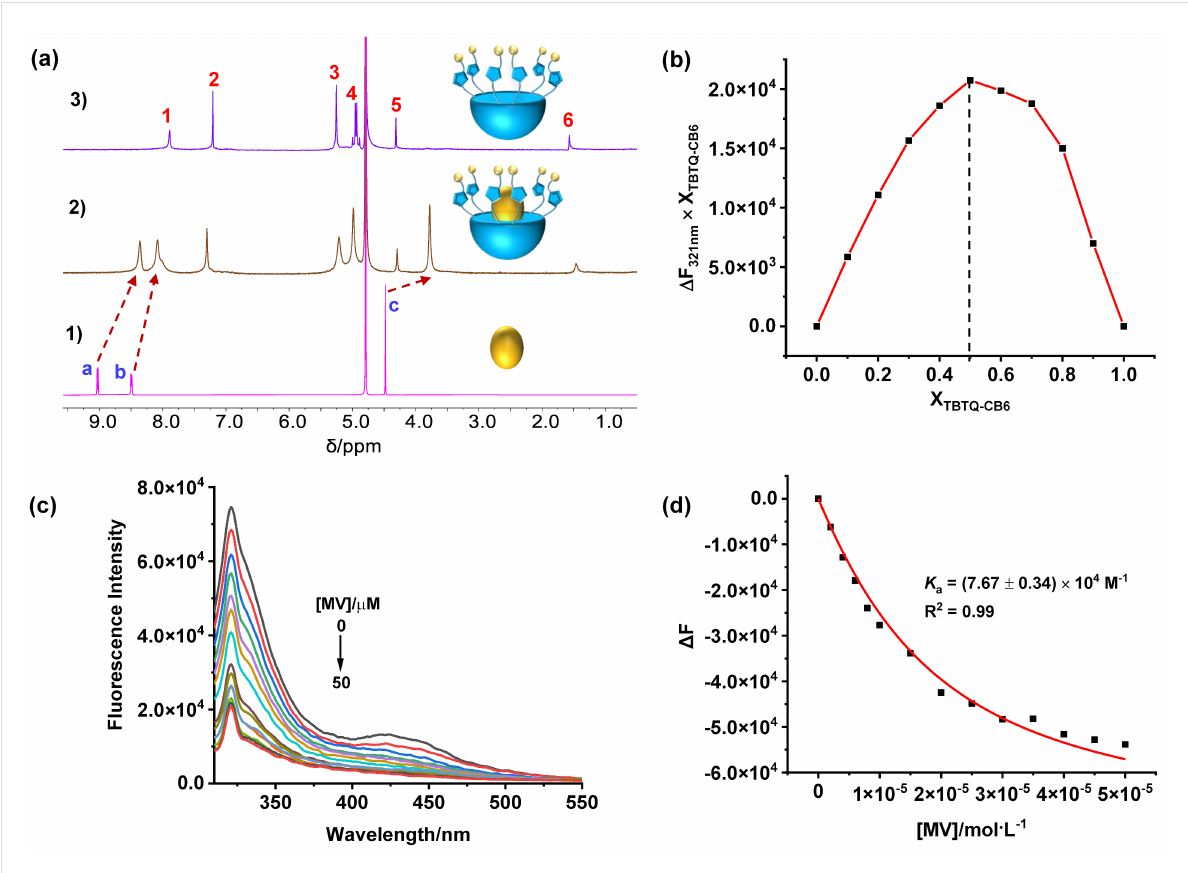
Figure 1: (a) 1 H NMR spectra (400 MHz, D 2 O, 25 °C) of (1) MV , (2) TBTQ-CB6 and MV , (3) TBTQ-CB6 with [ TBTQ-CB6 ] = [ MV ] = 3 mM in each case. (b) Job plot curve of TBTQ-CB6 and MV by plotting fluorescence changes at 321 nm against the molar fraction of TBTQ-CB6 (X TBTQ-CB6 ). (c) Fluorescence titration spectra of TBTQ-CB6 (10 μ M) with varying concentrations of MV in water ( λ ex = 290 nm). (d) Plot of Δ F vs [ MV ] at 321 nm according to (c) (the solid line was obtained from the nonlinear curve fitting).